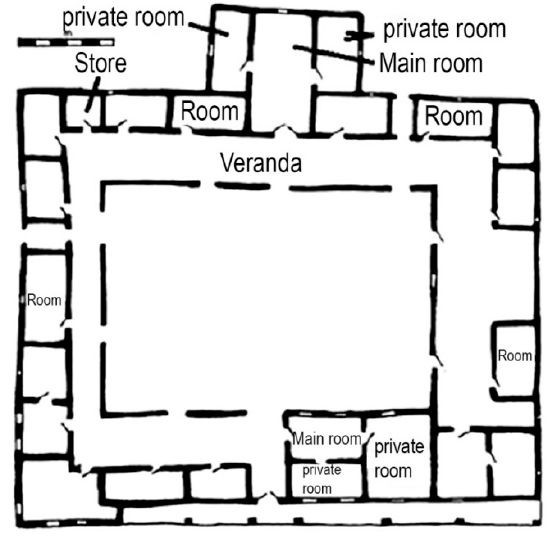
Figure 2. Yoruba compound house.